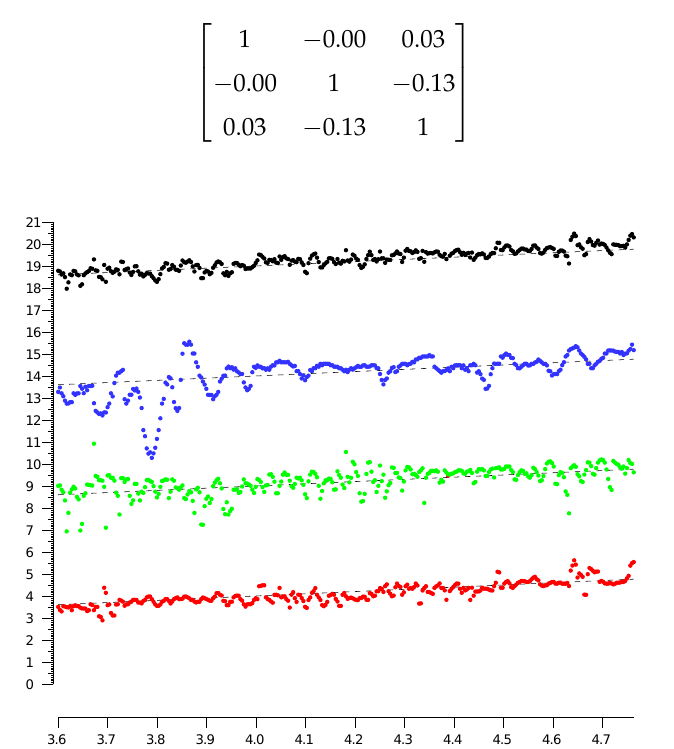
Figure7. Sampleplots(colored)ofreporteddistancesinthreechannels. Thetop(black)plotisaweighted average, which has only a bit over half of the average error in the individual plots. Horizontal axis: actual distance in meters. Vertical axis: reported distance in meters. (Note: the average slope of the plots is not equal to one, because the scales on the vertical axis and horizontal axes are different). (Individual plots are offset vertically to avoid